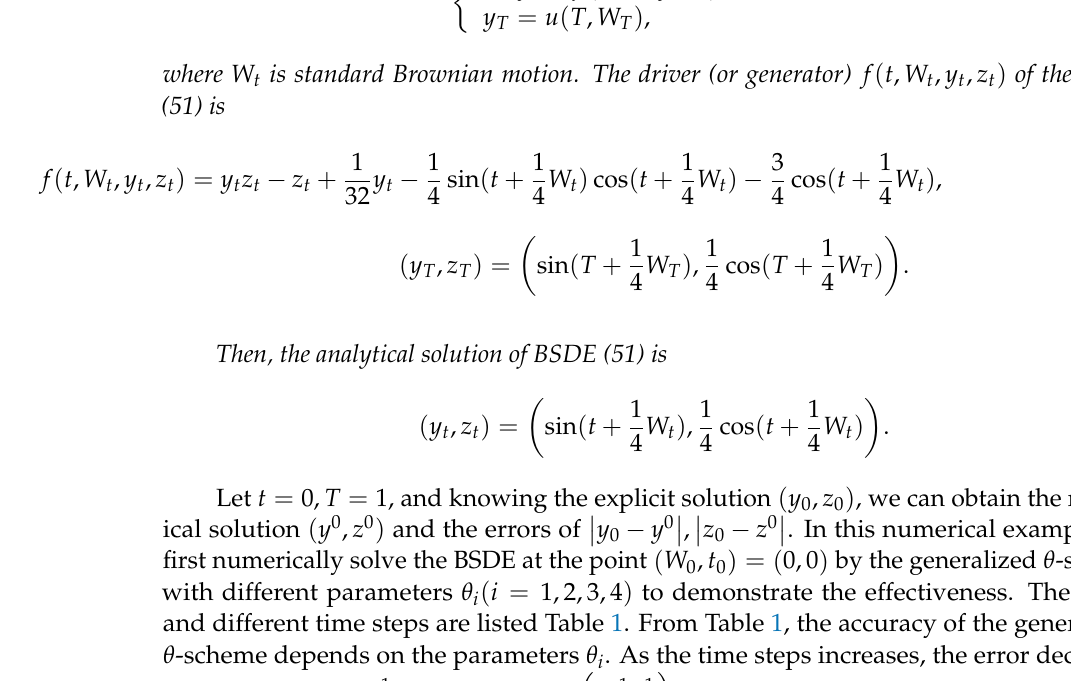
(cid:12) (cid:12) (cid:12) (cid:12) (cid:12) , for example. (cid:12) , (cid:12) z 0 − z 0 (cid:12) y 0 − y 0